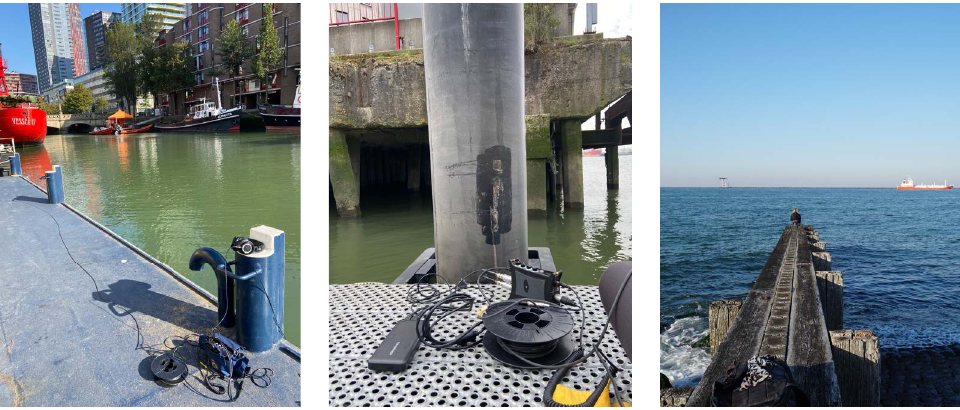
Figures 2, 3, and 4: Dock locations . Water station 47 (51.9169881, 4.4838441), 101 (51.9020667, 4.3718844) and Rotterdam port (51.9832262,